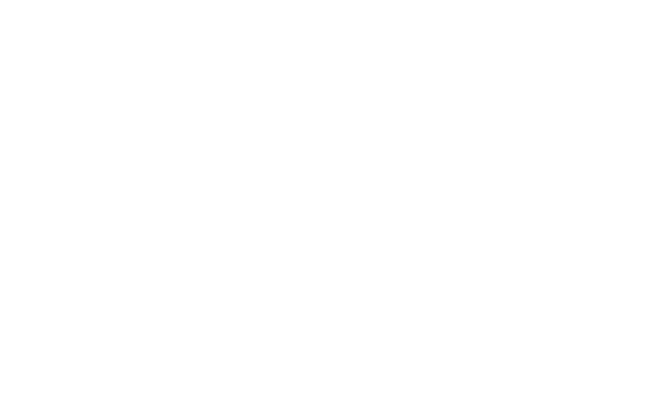
13 of 19 Figure 5. Increased HO ‐ 1 and NQO1 protein levels in lumbar spinal cord in sALS patients. Quanti ‐